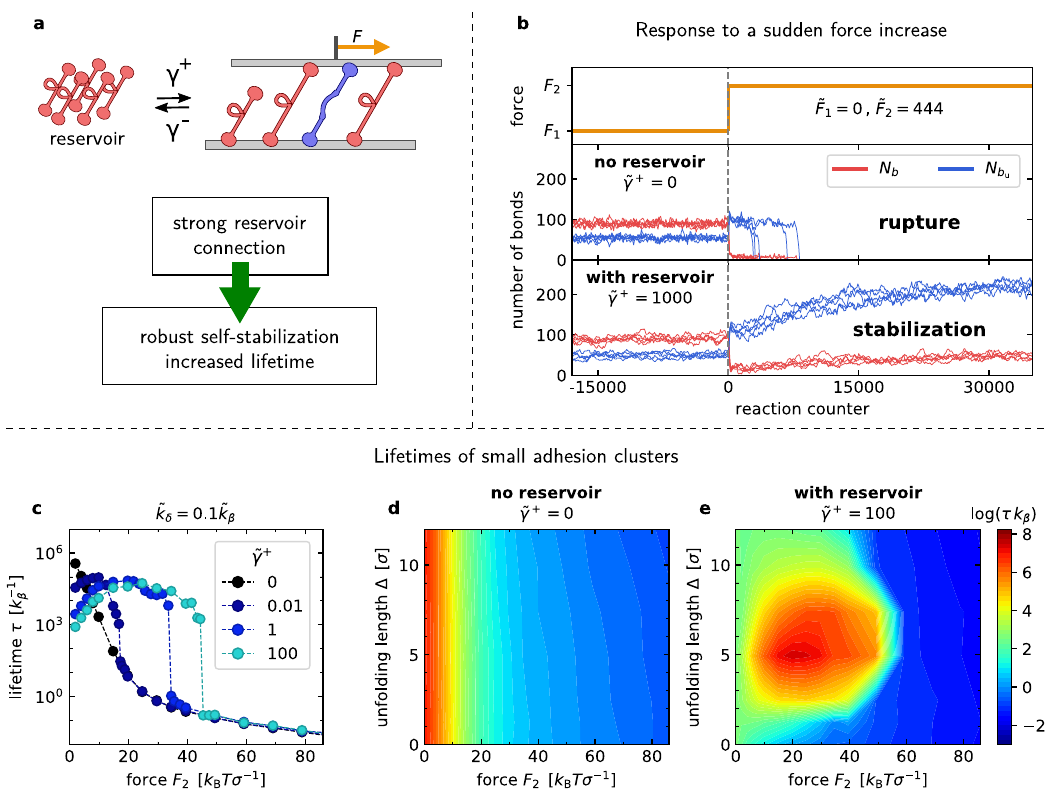
Fig. 4 Rupture behavior and lifetimes of adhesion clusters. a The reservoir-exchange rates γ ± control the association and dissociation of molecules with the adhesion. b Exemplary force response of adhesion clusters without reservoir connection and with strong reservoir connection. A force jump ampli fi es molecule unfolding. Without self-stabilization, the cluster does not reach a non-equilibrium steady state but dissociates shortly after force application. c Average lifetimes of the adhesion clusters with N * ≈ 10 for different values of γ ± with γ = γ + / γ − held constant. A strong reservoir connection results in an adhesion lifetime maximum at fi nite, non-vanishing external forces. Average cluster lifetimes as a function of force and the unfolding length Δ for k = 0.1 k = 1/ t γ ± = 0 ( d ) and γ ± = 100/ t δ β 0 and 0 ( e ). See Supplementary Notes I for other parameter